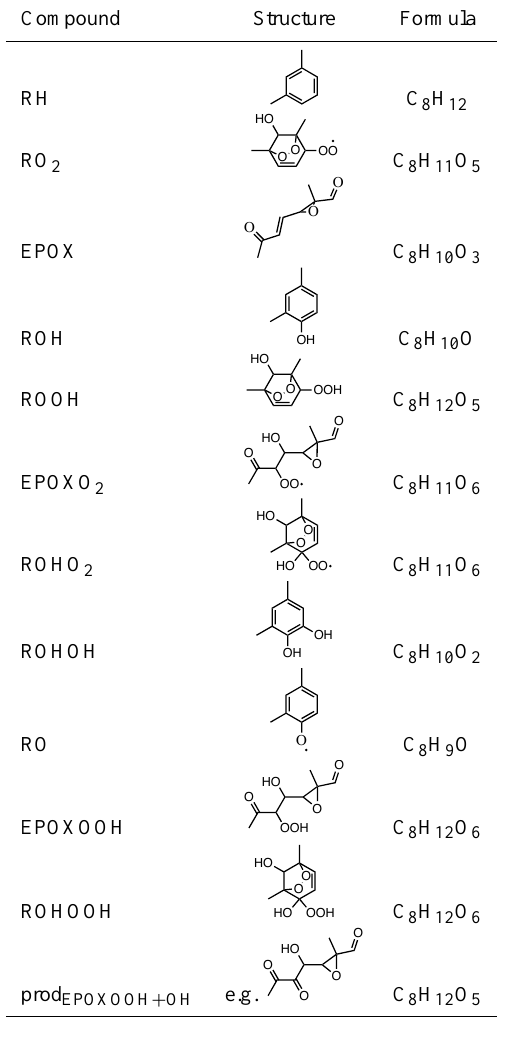
Table 4. Compounds represented in the photochemical model. Compound Structure Formula